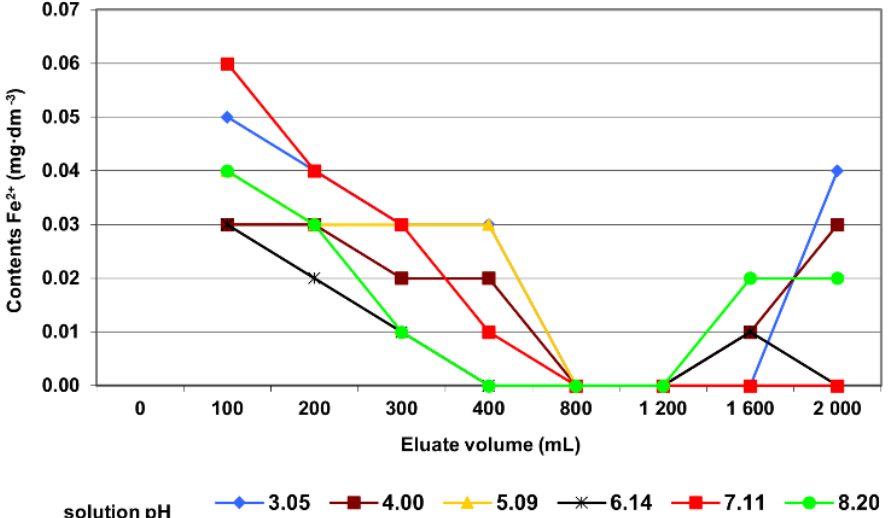
Figure 5. Contents of Fe 2+ ions in successive portions of the collected eluate depending on the pH of the initial leaching solution.